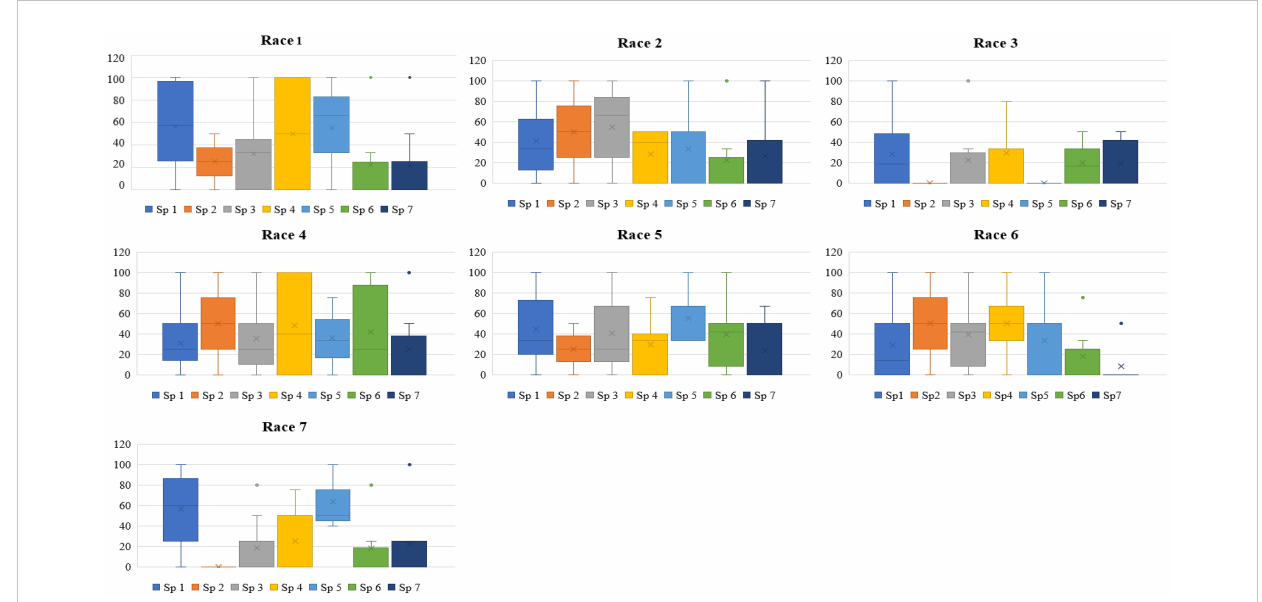
FIGURE 1 Box plot depicting disease incidence of each species of lentil against each race of Fusarium oxysporum f. sp. lentis screened during 2020-2021. Sp1: Lens culinaris sub sp. culinaris ; Sp2, L. c. subsp . tomentosus; Sp3, L. c sub sp. orientalis ; Sp 4, L. c. sub sp. odemensis ; Sp 5, L. lamottei ; Sp 6, L. nigricans ; Sp 7, L. ervoides . Race 1: MP-2; race 2, UP-9; race 3, RJ-8; race 4, DL-1; race 5, CG-5; race 6, UP-12; race 7, BR-27.